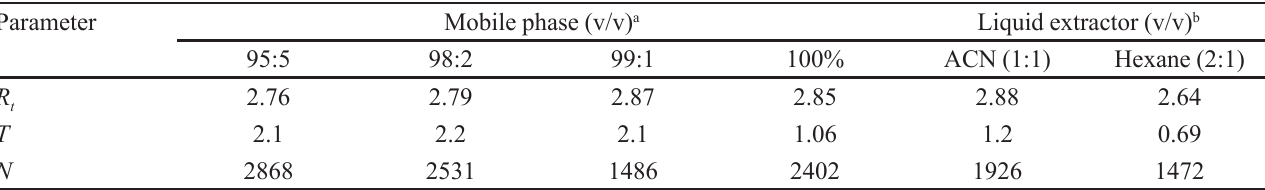
The parameters monitored were peak retention time ( R ), tailing factor ( T ), and theoretical plates ( N ) . t a The experiment was performed using mobile phase consisting of phosphate buffer (0.05 M) varying the ACN ratio. The experiment was carried out using phosphate buffer (pH 7.4, 0.05 M) as mobile phase. b Tests varying the composition of liquid extractor